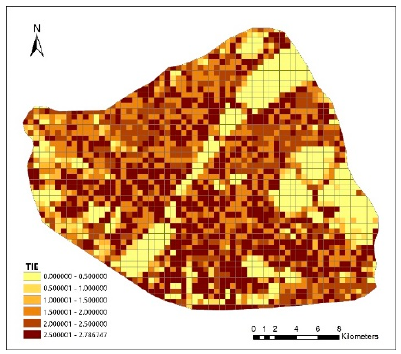
Figure 8. Topic information entropy (TIE) based on the H-LDA model.